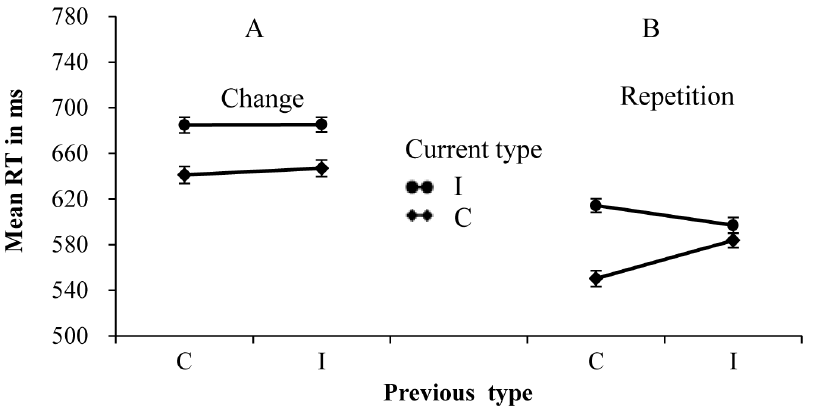
Figure 2. Mean RTs for each combination of current type and previous type. Panel A shows the results on change trials of all participants. Panel B shows the results on the response or S-R repetition trials of all